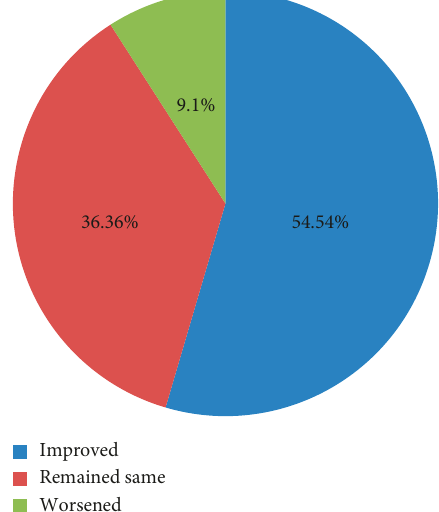
Figure 2: Outcome of visual acuity (VA) after surgery.